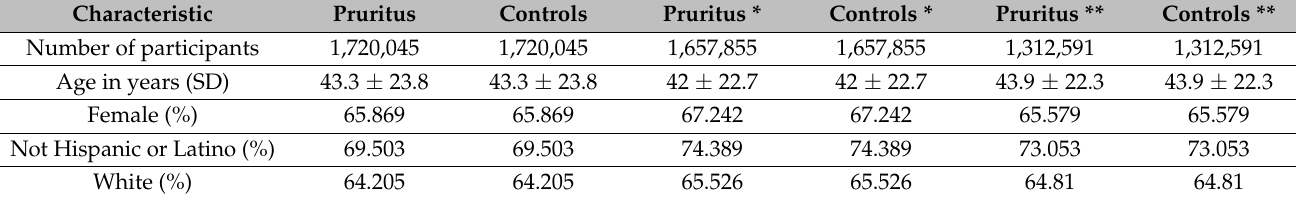
Table 1. Cohort description for pruritus patients. Abbreviations: SD: standard deviation. * Cases (pruritus) and controls with elevated bilirubin or urea nitrogen concentrations in serum, plasma, or blood were excluded from analysis. ** Cases (pruritus) and controls with any other dermatosis associated with itch were excluded from